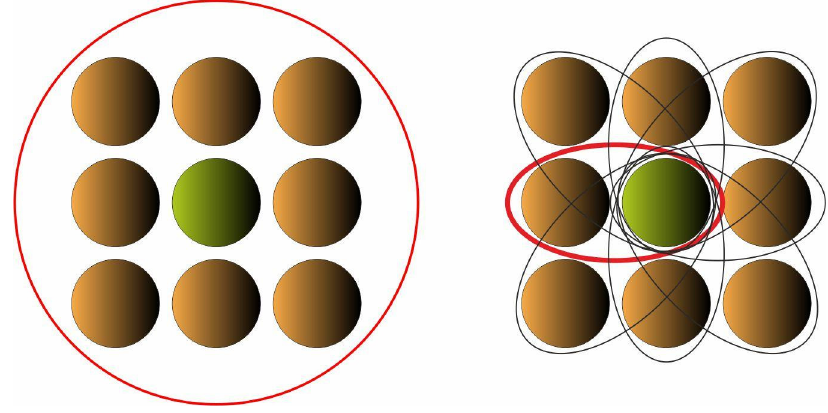
Figure 2. The cell neighborhood. The neighboring cells collide with the central one. From a topology generation point of view, the interpretation is that the central cell remains solid, or is driven to become a void one (Figure 3).